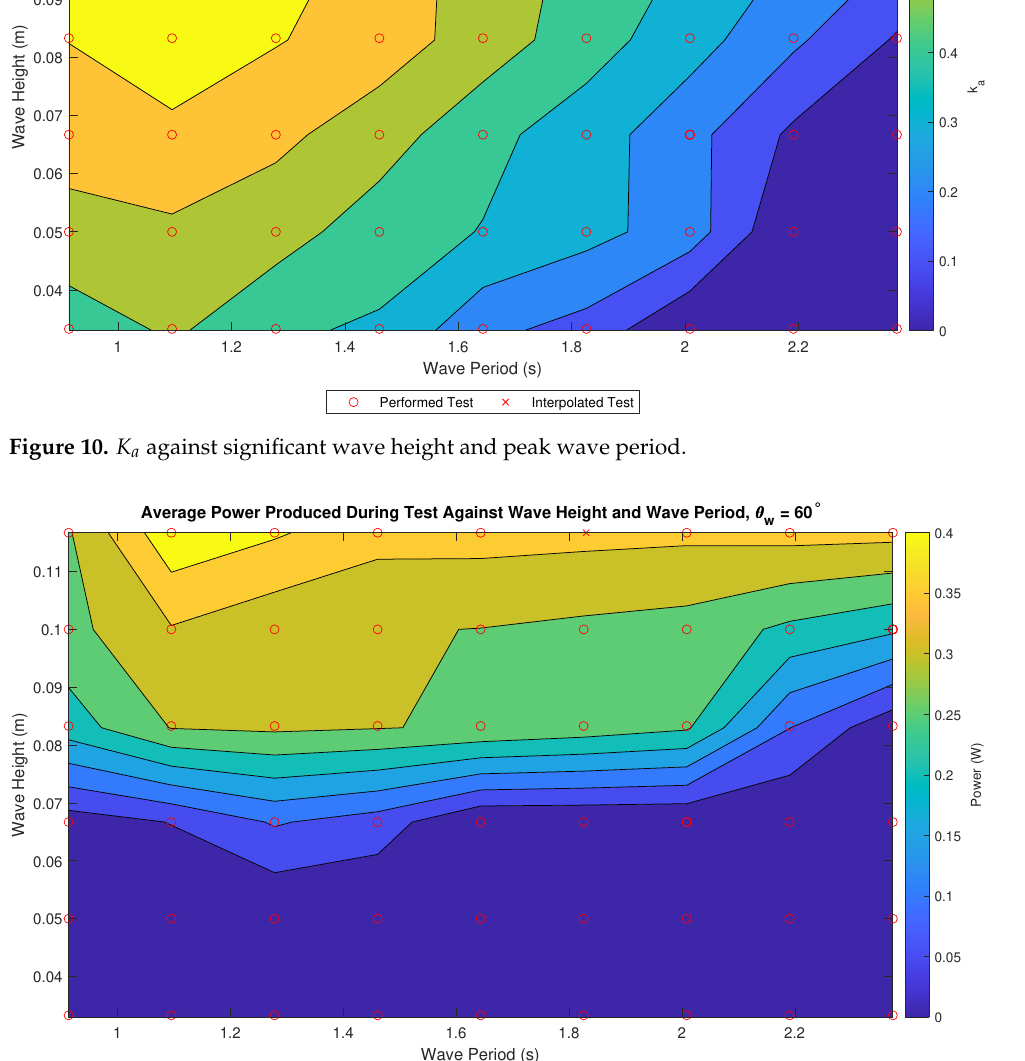
Figure 11. Collected power as measured through flowmeter readings over the course of a test. Figures 13 and 14 show the CW and CWR, respectively. The highest CWR occurs at H s = 0.08 m and T p = 1.09 s. While this is not the most energetic test, nor the test with the highest overall power captured, it is the test that has the greatest efficiency in capturing power. This suggests that the device is capturing more than the power generation system can accommodate during tests with higher power